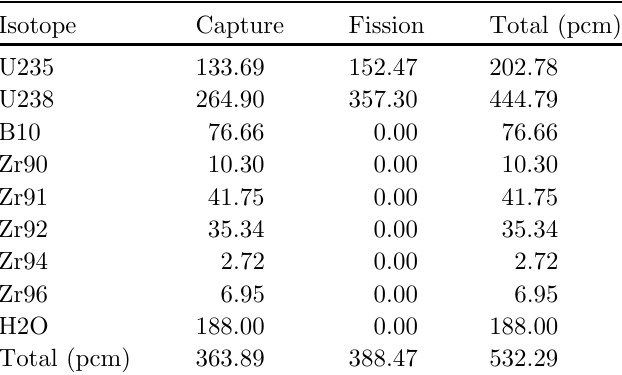
Table 3. Uncertainty on reactivity due to nuclear data with CRONOS2 sensitivities at 4 energy groups.